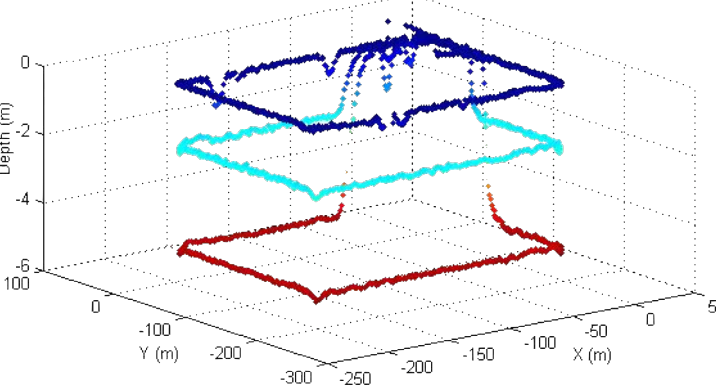
Figure 20. Square mission of MAYA at surface, 3 m and 5 m depth at Supa Dam,